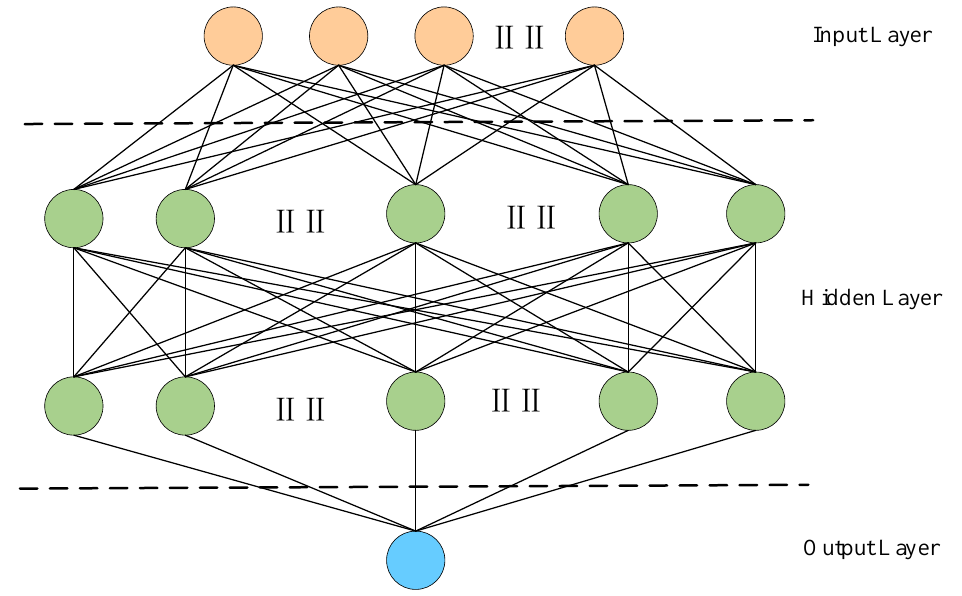
Figure 3. The structure of LSTM neural network.